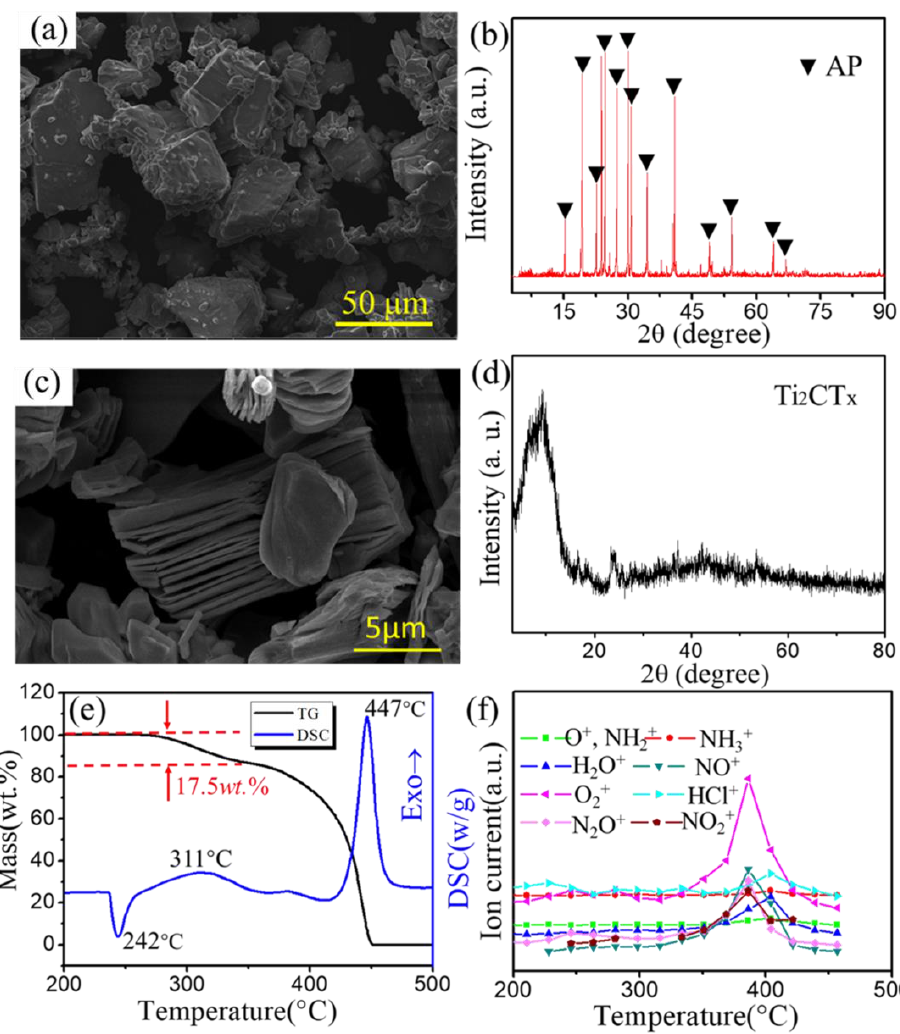
Figure 1. ( a ) SEM image and ( b ) XRD of AP; ( c ) SEM image and ( d ) XRD of Ti 2 CT x ; ( e ) DSC and TG curves for the thermal decomposition of AP; ( f ) ion intensity curves of pure AP during the thermal